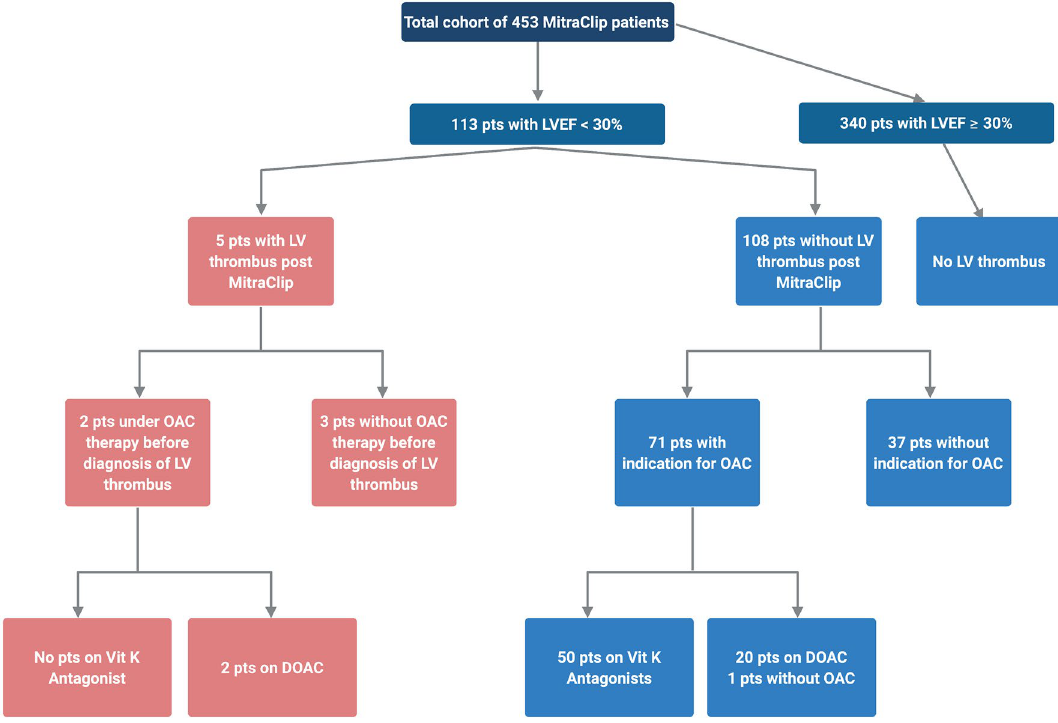
Figure 1. Prevalence of LV thrombus and anticoagulation therapy in total cohort.